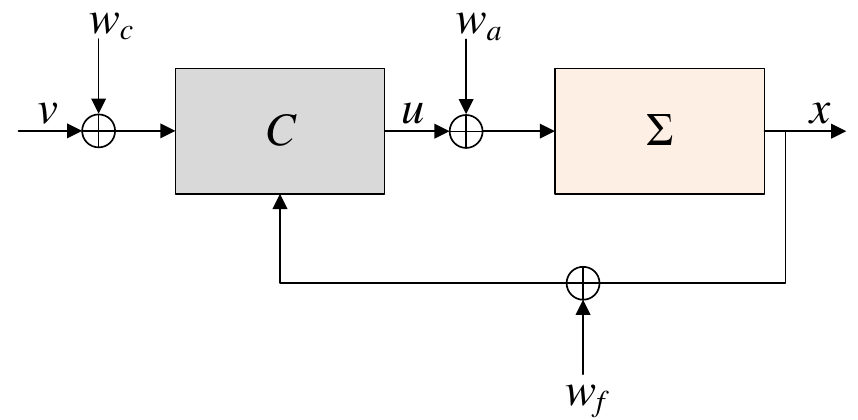
Figure 5. Fault-tolerant corrective control